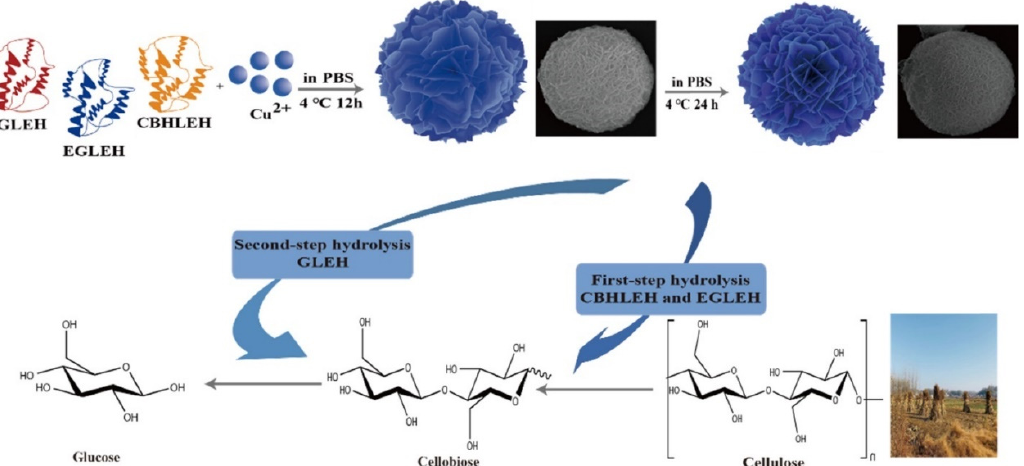
Figure 4. Schematic of the formation mechanism of ECG-NFs and the functional mechanism of cellulase. Reproduced with permission from [79], American Chemical Society, 2021.